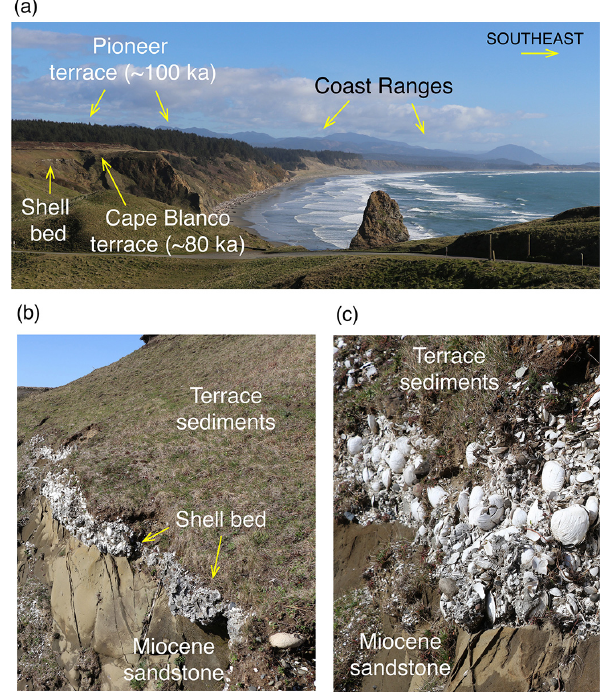
Figure 20. Photographs of the Pioneer ( ∼ 100ka, MIS 5c?) and Cape Blanco ( ∼ 80ka, MIS 5a?) marine terraces (a) in the Cape Blanco area, with closeups of the wave-cut bench on Miocene sand- stone, shell bed, and terrace sediments (b, c) . All photographs by Daniel R.